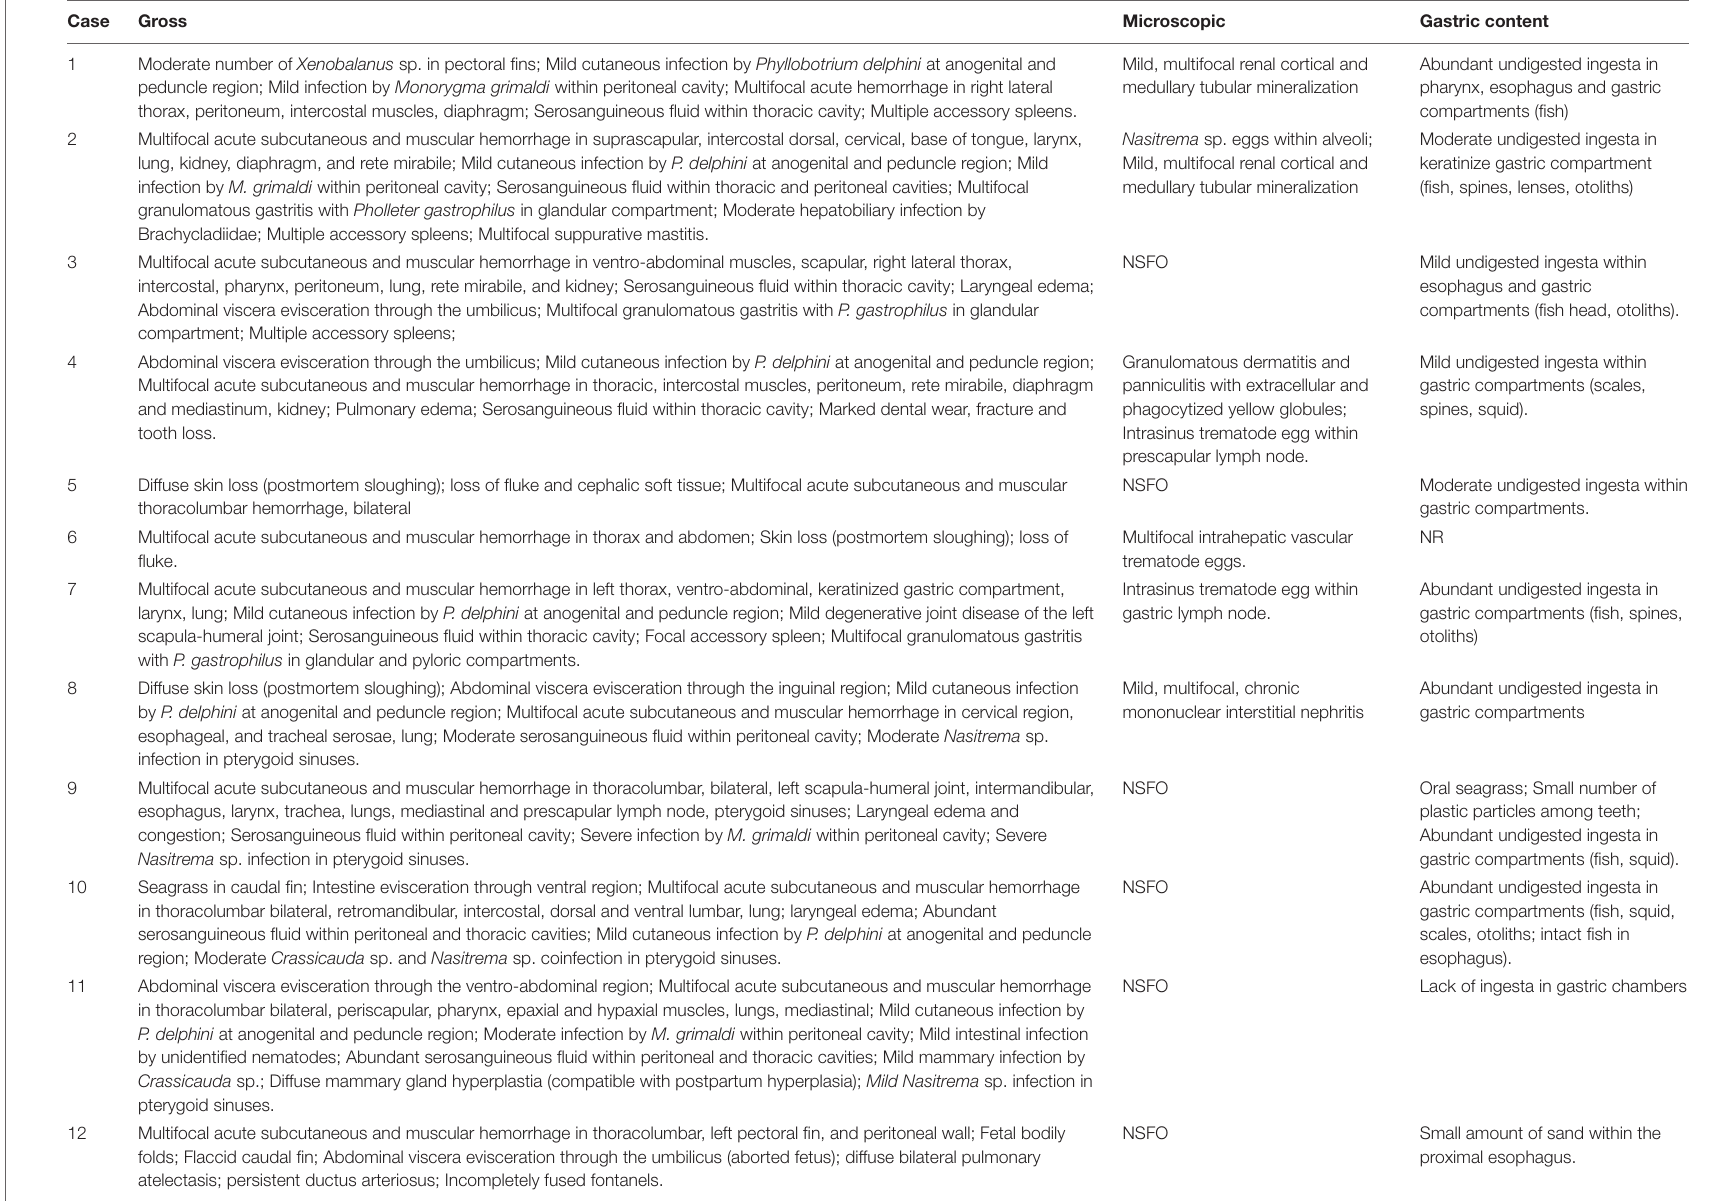
TABLE 2 | Pathologic findings in rough-toothed dolphins ( Steno bredanensis ) included in this study. Case Gross Microscopic Gastric